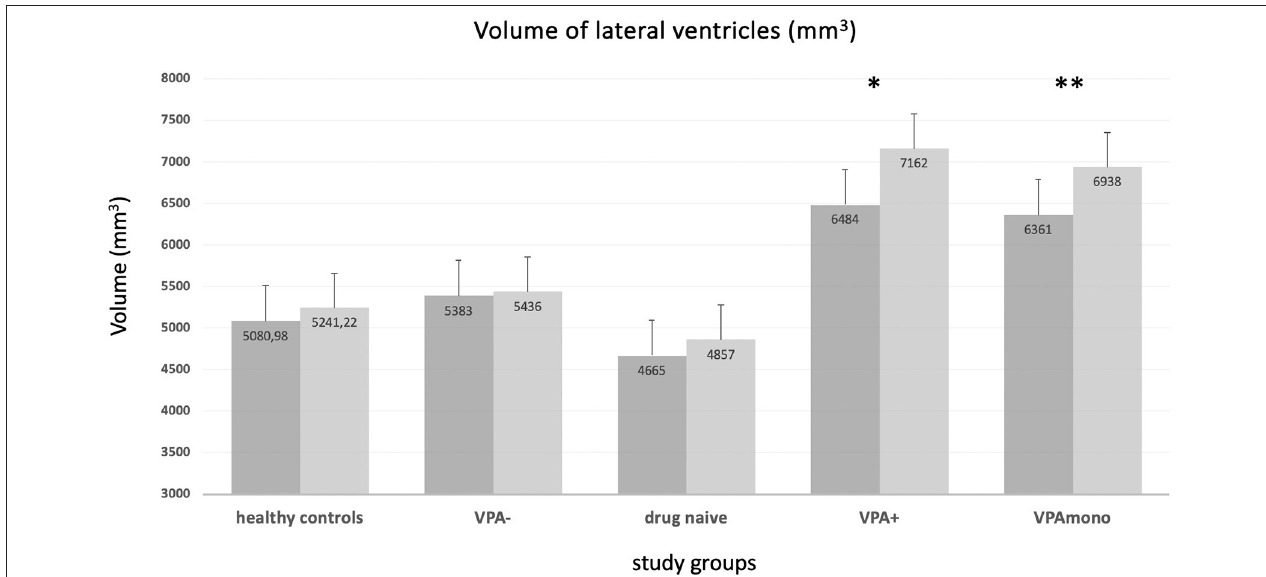
FIGURE 4 | Volume of the lateral ventricles (means, mm 3 ) in the different groups. VPA + (*) and VPA mono (**) groups showed enlarged ventricular volumes (both right and left ventricle) with respect to every other group. No significant differences were present for healthy controls, VPA-, and drug-naïve groups (see text and Table 3 ). VPA + : epilepsy patients using valproate (in mono or polytherapy); VPA-, patients not using valproate; VPA mono, patients using valproate in monotherapy. Bars represent the standard error of the